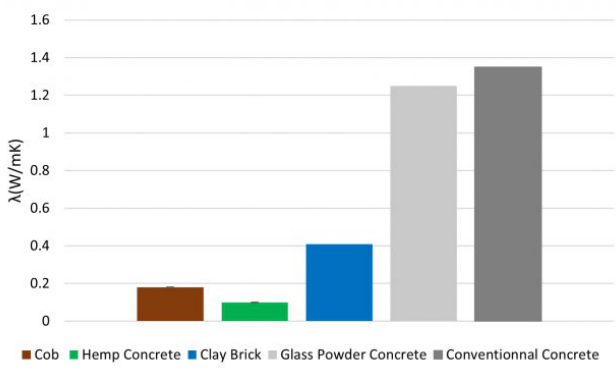
Figure 7. Comparison of thermal conductivity of different materials.